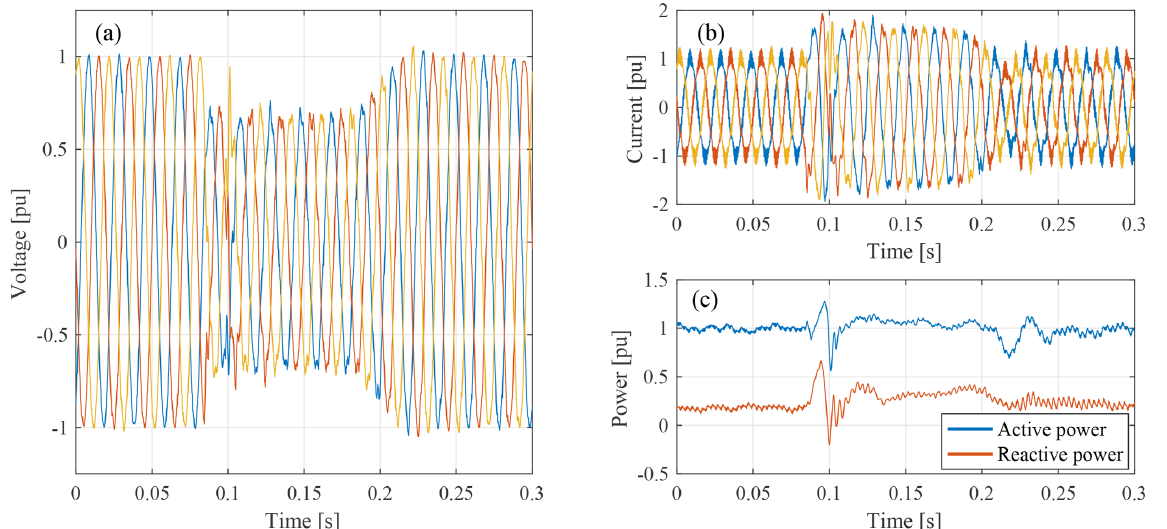
Figure 6. Wind turbine tested for LVRT at full power: three-phase voltage (a) and current (b) , plus active and reactive power output (c) .